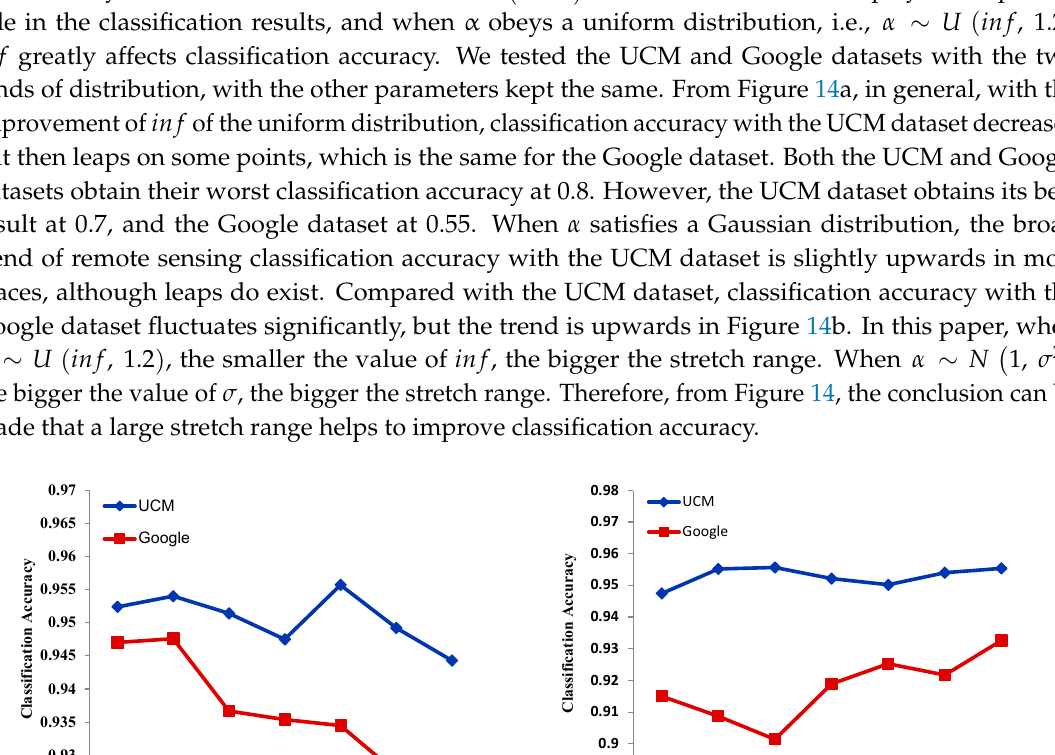
Figure 13. The relationship between feature length L and classification accuracy.